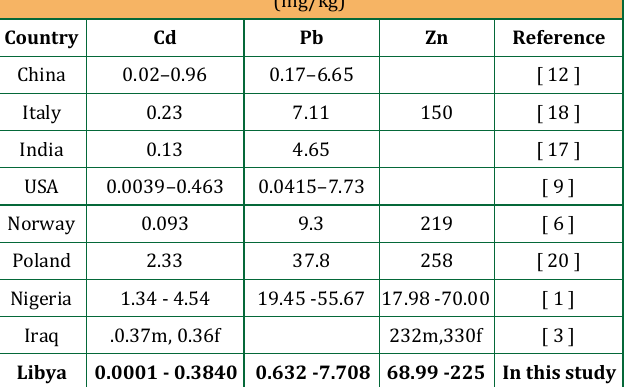
Table 6: Comparison of Hair Metal Levels in Different Countries